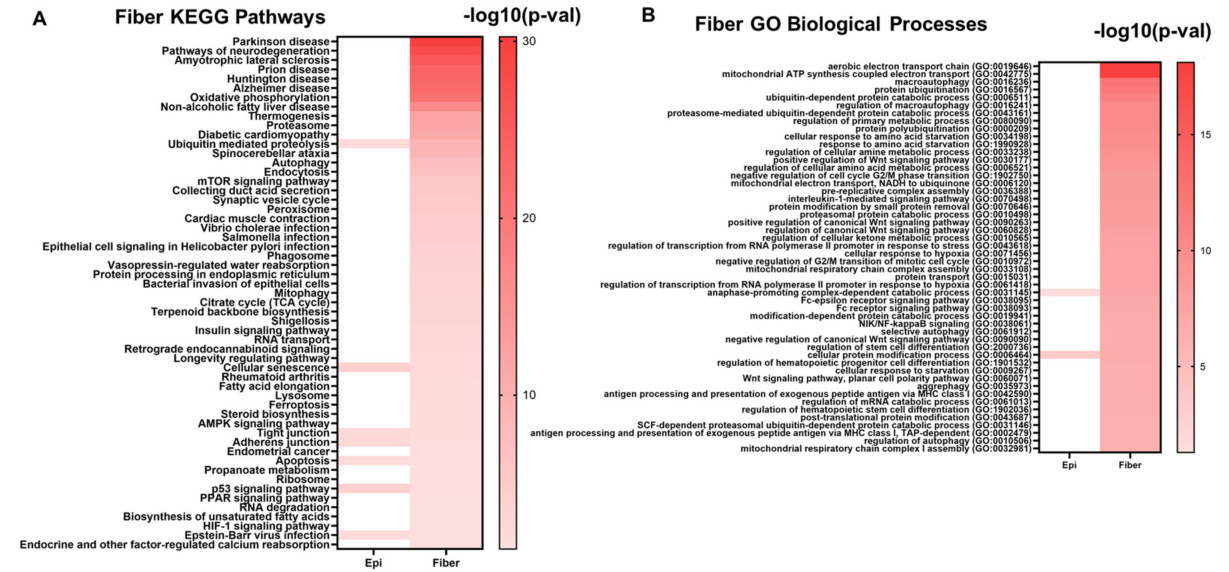
Figure 8. The top enriched KEGG pathways ( A ) and GO biological processes ( B ) associated with the evolutionarily conserved fiber cell genes. Darker colors in the heatmap represent smaller p -values. Pathways and GO Biological processes that are also associated with epithelial cell genes are also indicated in the heatmap in the “Epi”